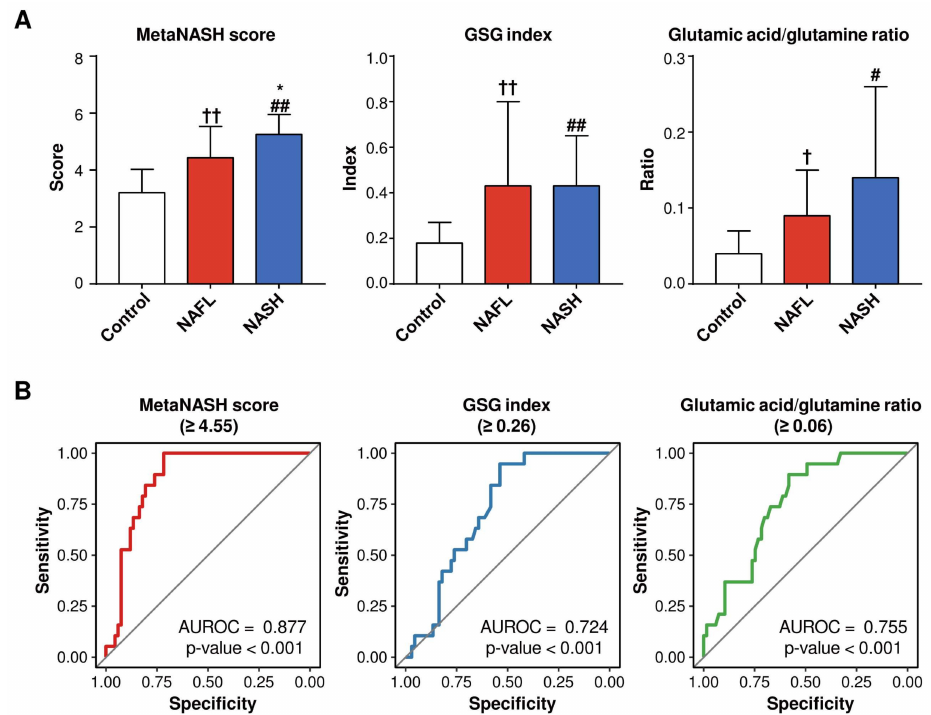
Figure 6. Comparisons of the MetaNASH score, the GSG index, and the glutamic acid/glutamine ratio between the study groups and their performance in the discrimination of NASH. ( A ) MetaNASH scores, GSG index values, and glutamic acid/glutamine ratios in the study groups. Data are expressed as the mean ± SD. The statistical significance of each variable of the NASH group compared to the control and NAFL groups was evaluated by post hoc analysis. † , p < 0.05; and †† , p < 0.01 for NAFL vs. control: # , p < 0.05; and ## , p < 0.01 for NASH vs. control: *, p < 0.05 for NASH vs. NAFL. ( B ) Performance of the MetaNASH score, the GSG index, and the glutamic acid/glutamine ratio in distinguishing NASH in the whole